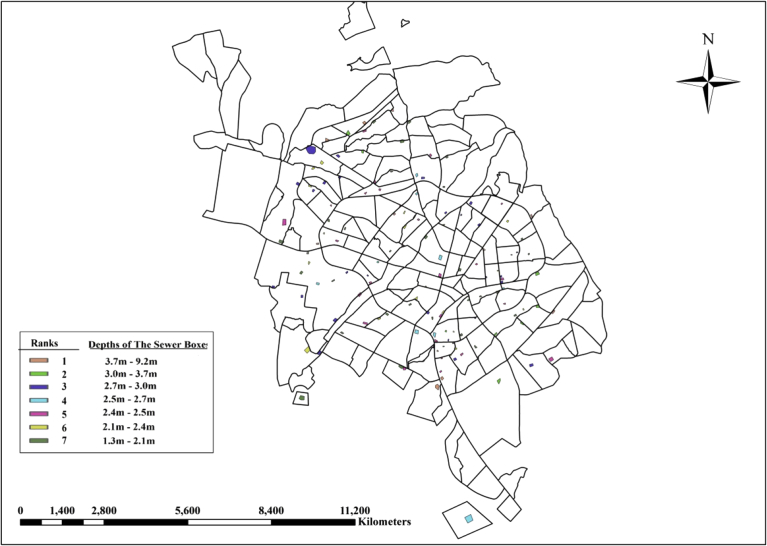
Classification of the nominated areas based on the depth of the sewer box at nominated area.